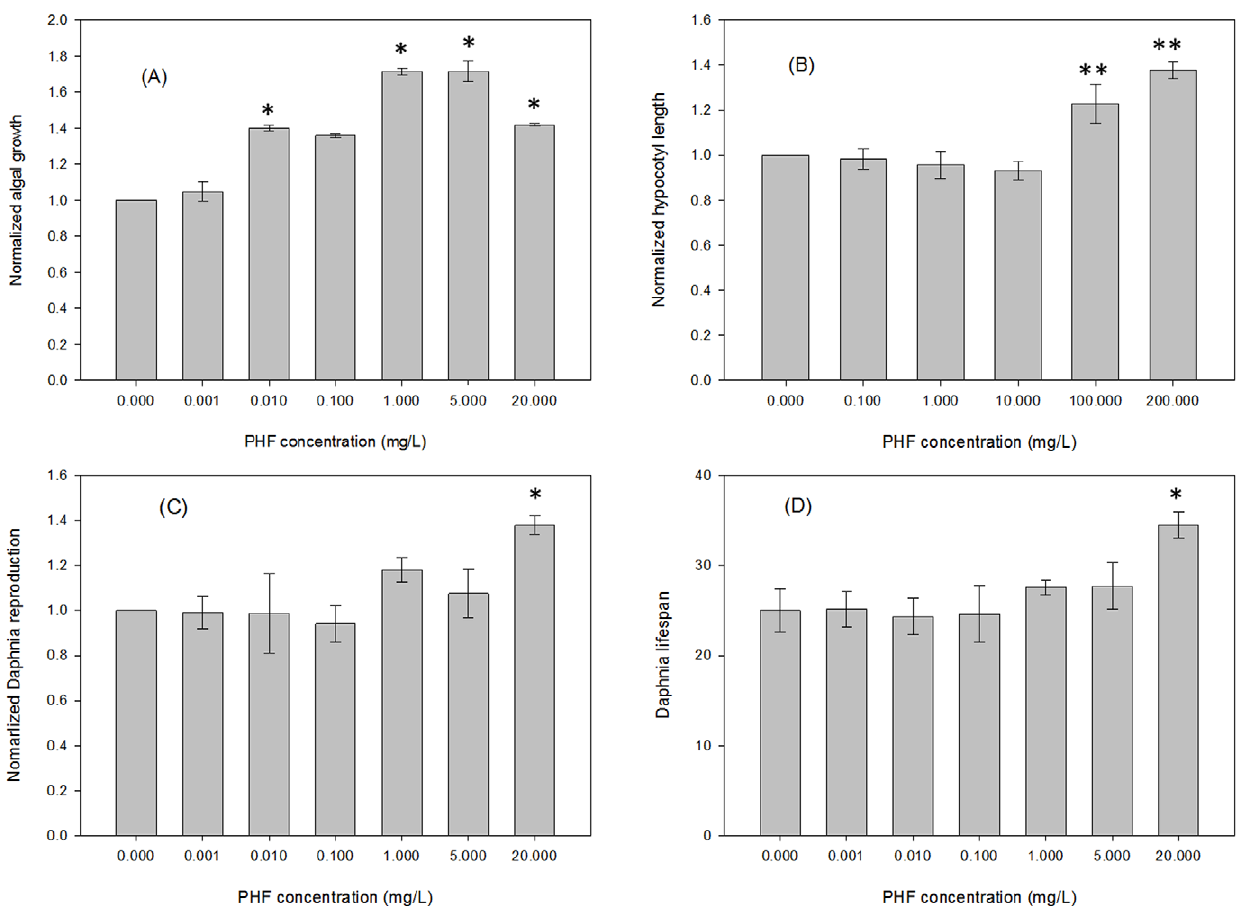
Figure 2. Effects of polyhydroxy fullerens (PHF) on growth and/or lifespan. (A) Normalized algal growth compared to untreated controls. The cultures were grown in the presence of the treatment for 4 days (n=9). (B) Normalized Arabidopsis hypocotyl growth against untreated controls. Data represent mean of three trials, wherein each trial comprises at least 25 seedling measurements. (C) Normalized Daphnia reproduction as measured by the number of neonates produced over the lifetime of 5 mature daphnids (n=4). (D) Lifespan of tested daphnids at concentrations from 0.001 to 20 mg/L (n=20). Error bars indicate standard error of the mean. *: p , 0.05; **: p , 0.01.